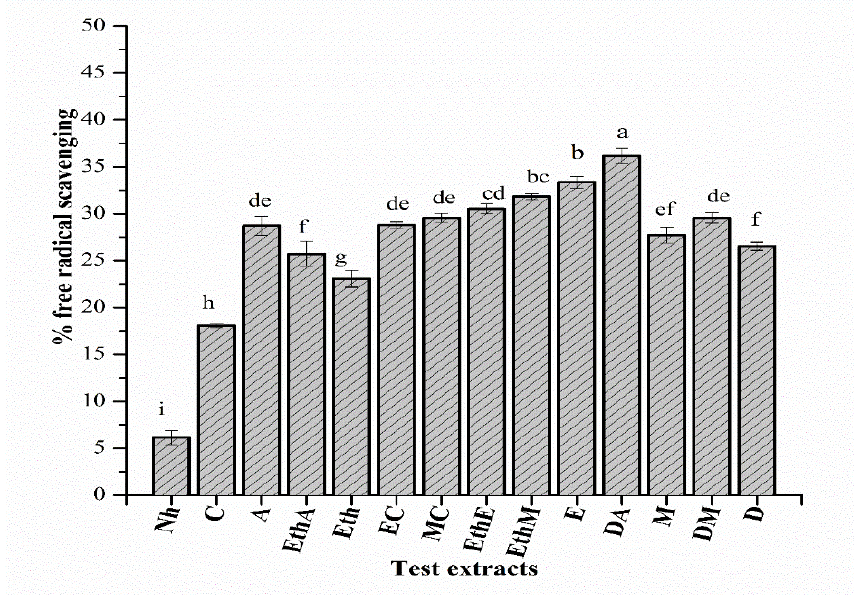
Figure 3. Percent free radical scavenging activity (mean ± standard deviation) after triplicate inves- tigation is shown. a – e represent the significance of results. Samples that display different alpha- bets were significantly different at p < 0.05.